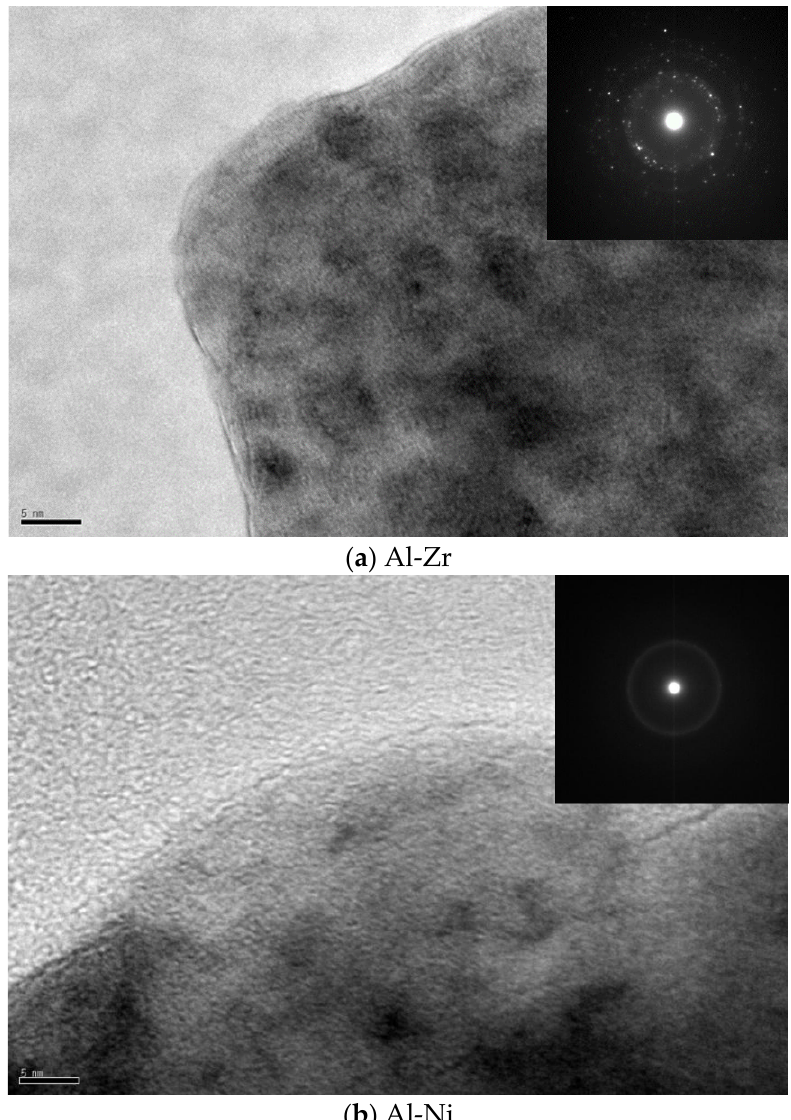
Figure 2. The transmission electron microscopy (TEM) image and selected area electron diffraction (SAED) patterns of Al-Zr and Al-Ni alloy powders.